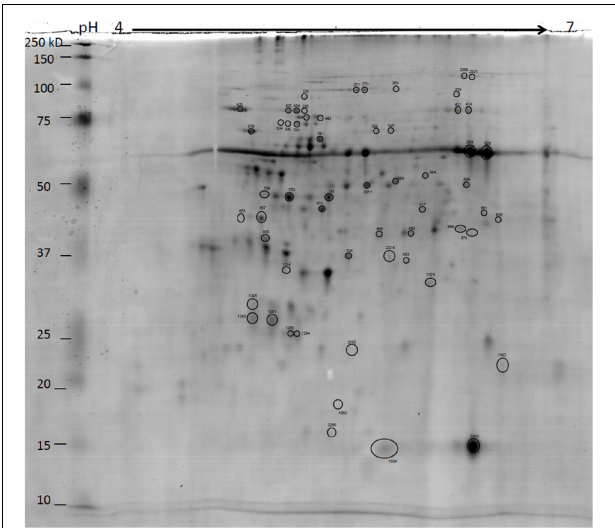
FIGURE 3 | Representative 2DE gels of coffee leaf proteins. Circled spots that significantly changed in abundance between Greenforce CuCa (G), ASM (A) and Control (C) at 3, 5, and 7 dat and 2 and 4 days after inoculation (i) with H. vastatrix (Hv) [one way ANOVA analysis was performed using a p- value < 0.05 and Fold Change > 1.5.] The proteins were successfully identified by MALDI-TOF/TOF-MS (detailed information on Table 2 ). Gels were stained in Colloidal Coomassie Blue.